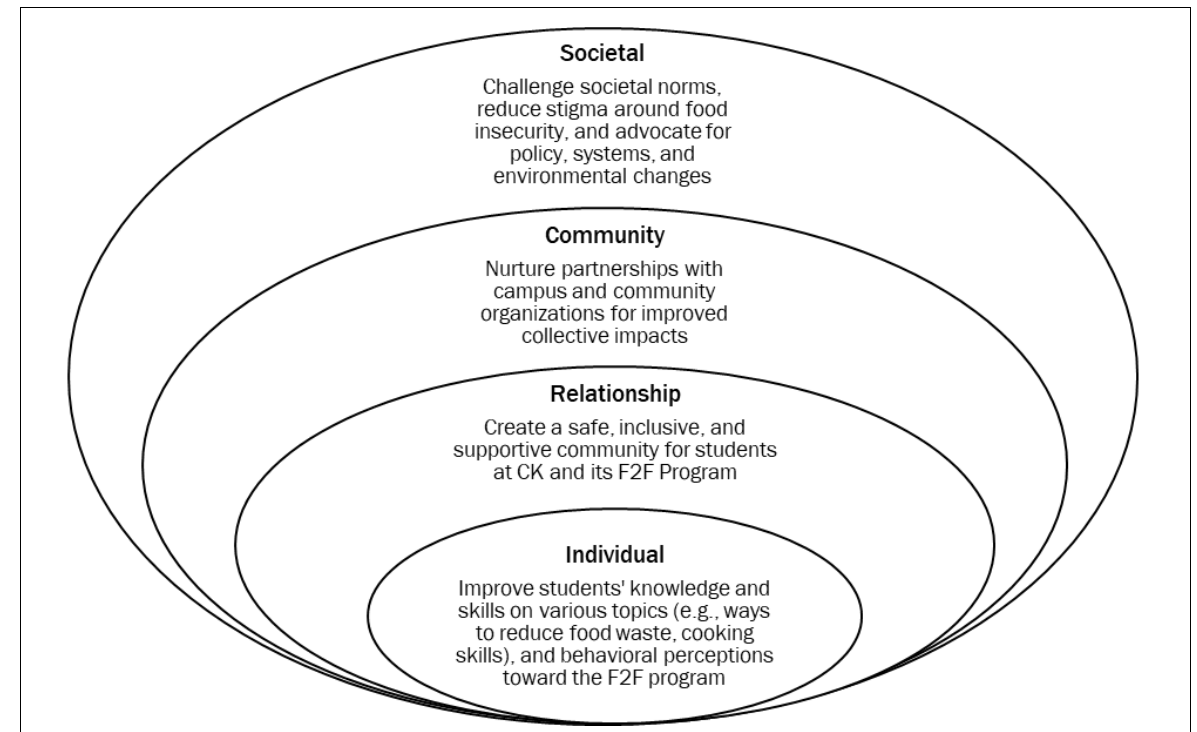
Figure 1. Application of the Social-Ecological Model in Campus Kitchen at the University of Kentucky (CK) and its Farm-to-Fork (F2F)